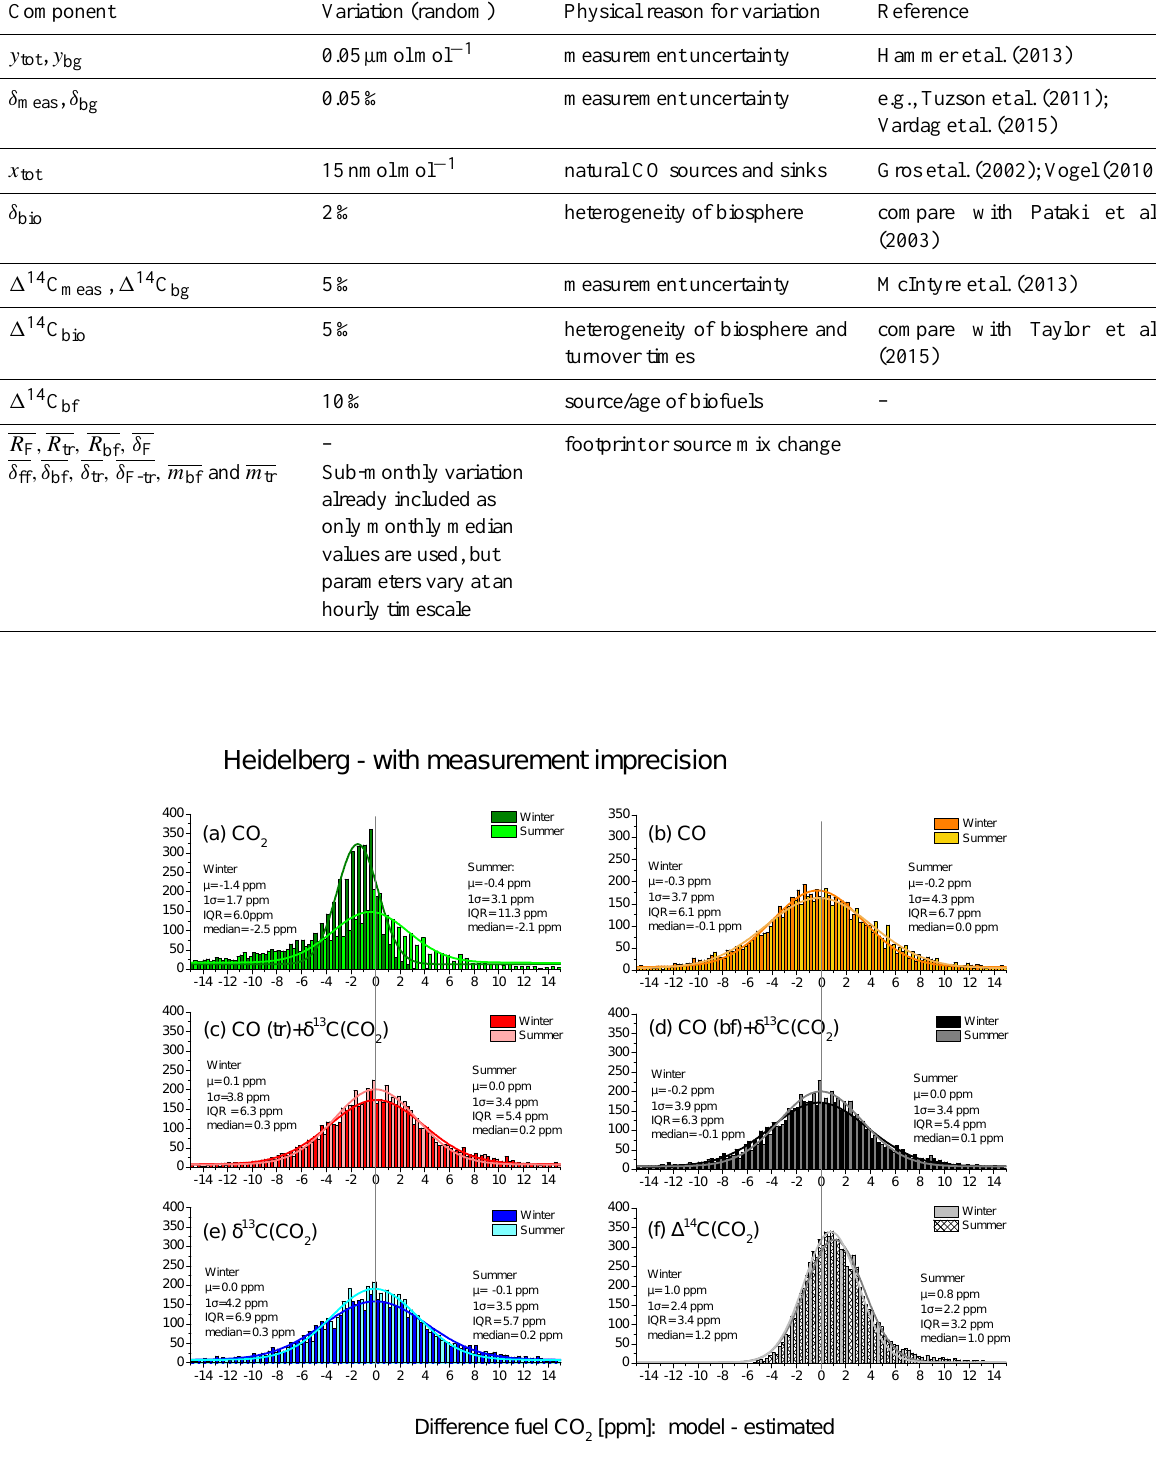
Figure 5. Same as Fig. 1 but now also including measurement